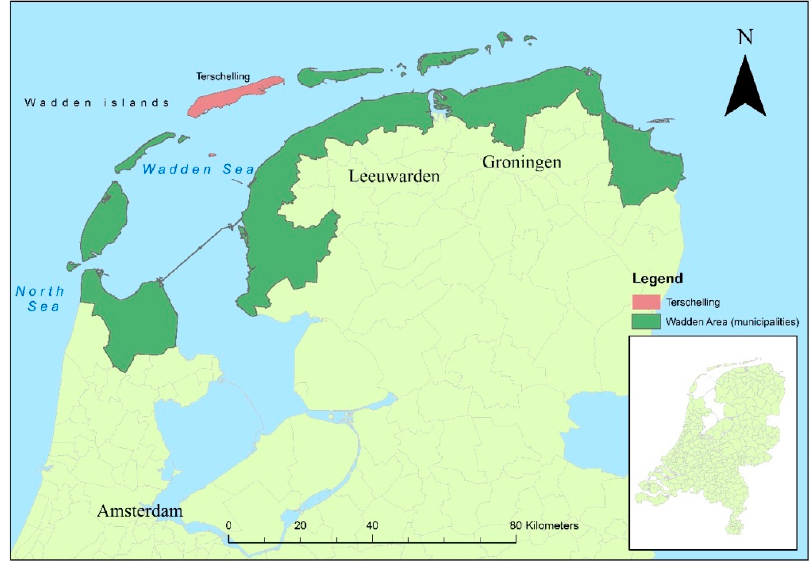
Figure 1. Map of the northern Netherlands showing the location of Dutch Wadden and Terschelling.